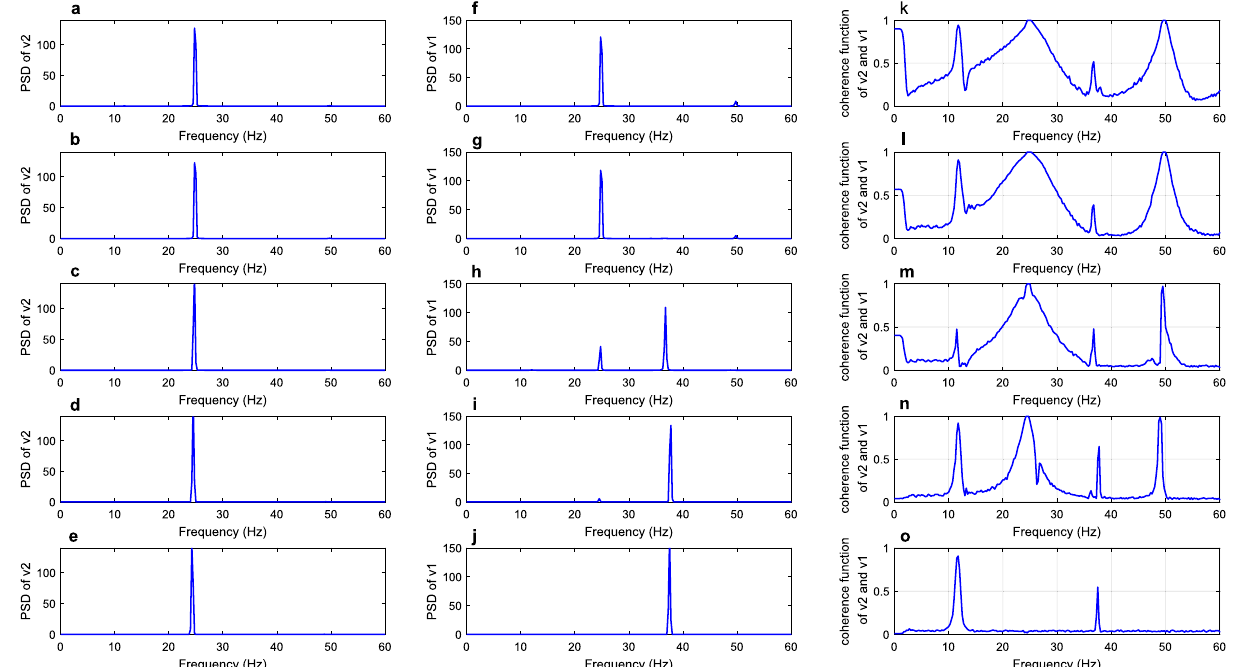
projection from v2 to v1 were in turn = 20, 15, 10, 5 and 0.